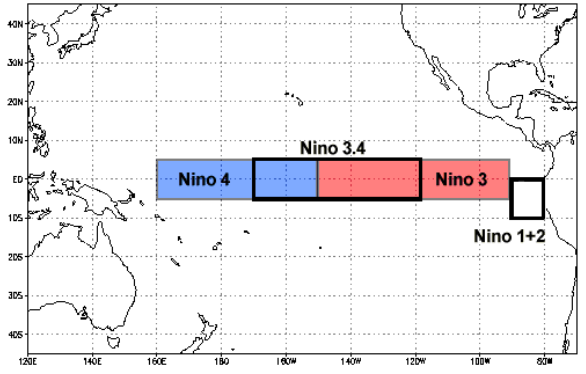
Figure 1. The regions of El Niño (NOAA 1, http://www1.ncdc.